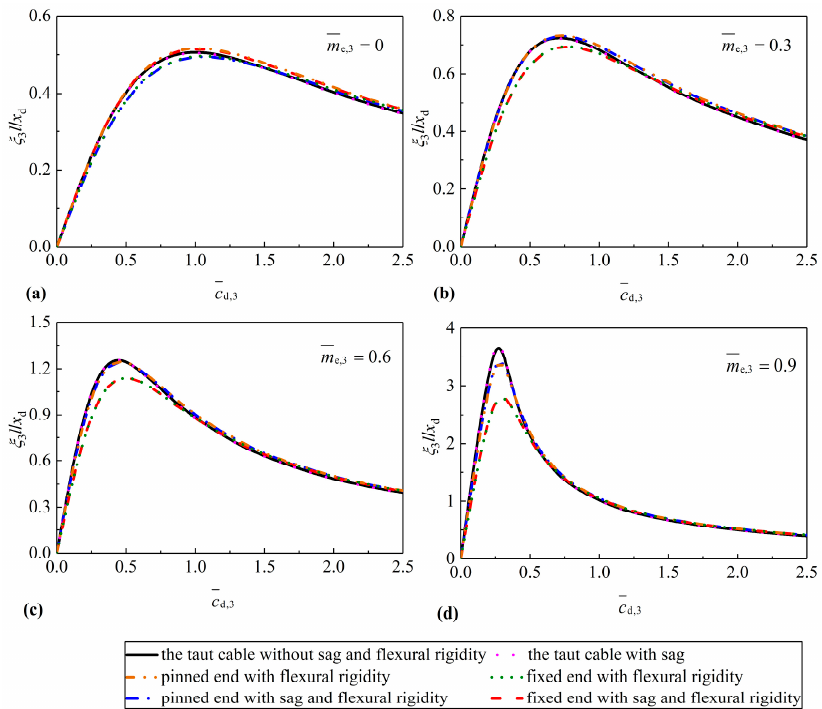
Figure 13. The second supplemental modal damping ratio of the long cable versus damping coefficient for various inertial masses: ( a ) m e,2 = 0; ( b ) m e,2 = 0.3; ( c ) m e,2 = 0.6; ( d ) m e,2 = 0.9. Appl. Sci. 2019 , 9 , x FOR PEER REVIEW